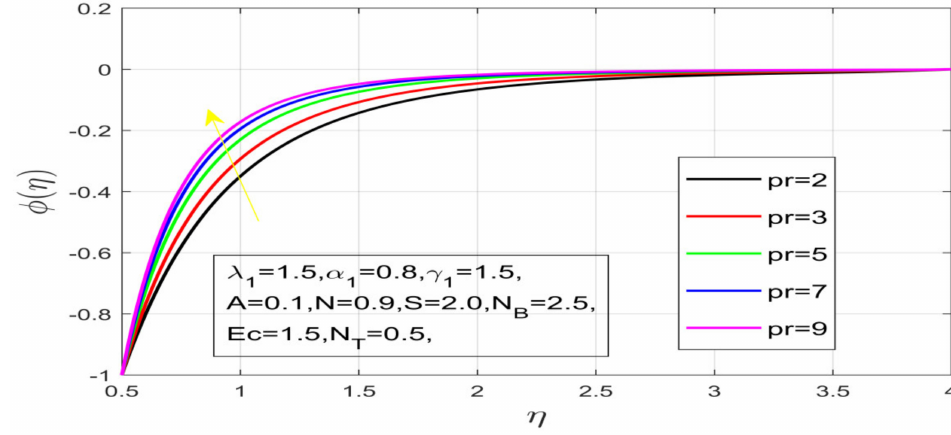
Figure 20. Variation in Pr on concentration.